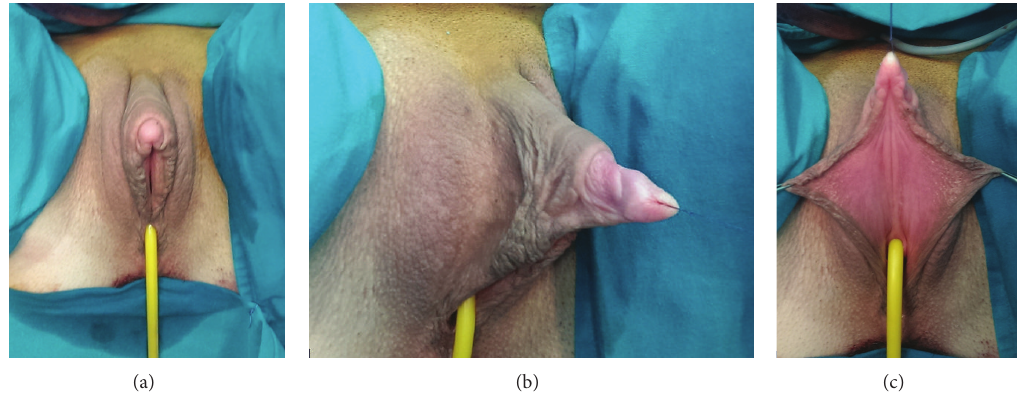
Figure 2: Preoperative appearance of genital area. (a) Ventral aspect. Clitoral bodies and glans are hormonally enlarged. Labia majora resemble scrotums. (b) Lateral aspect of hypertrophied clitoris. (c) Wide urethral plate between the glans and native urethral